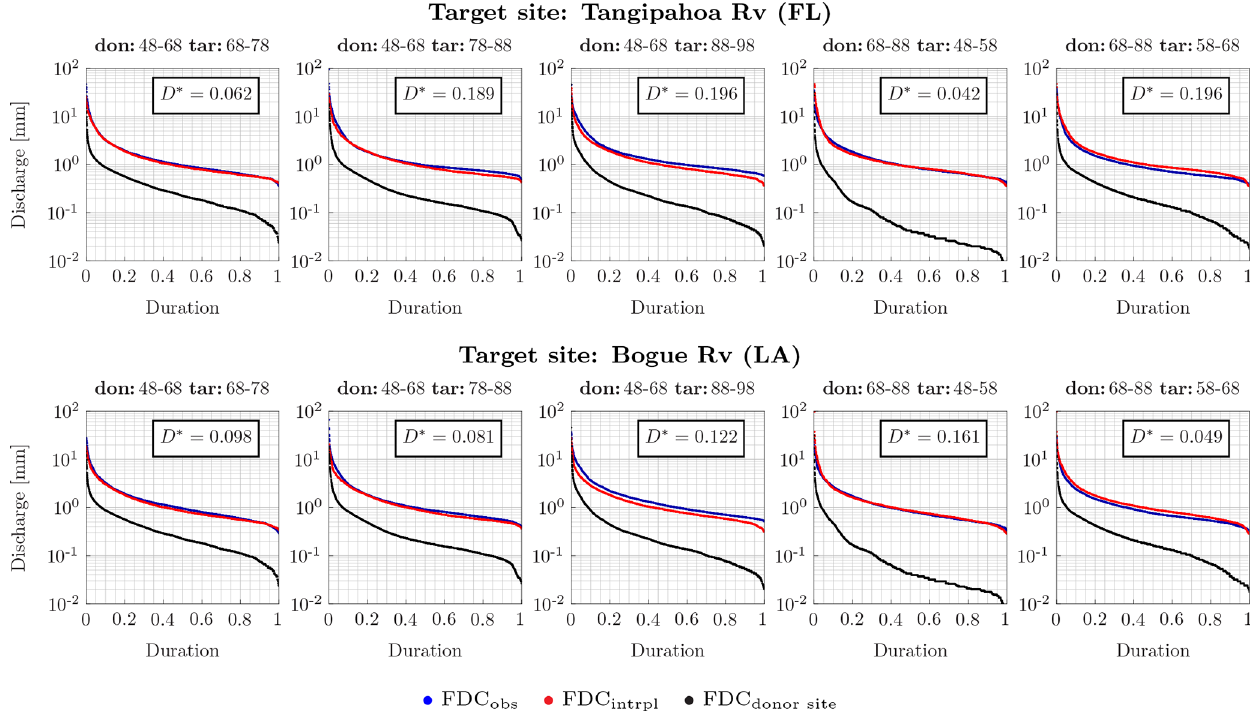
Figure 7. Interpolated FDC at Tangipahoa River (FL) and Bogue River (LA), in the upper and lower panels, respectively. The donor basin is Blanco River (TX). The donor years are a 20-year time window from October 1948 to September 1968 and from October 1968 to September 1988. Target years are the decades shown above each panel. Blue and red dots are the observed and interpolated FDC at the target basin during the target period, respectively; the black dots are the observed FDC at the donor basin during the target period. In each box the Kolmogorov–Smirnov distance between observed and interpolated values, D ∗ , is reported. The p value of the test is always around zero, but for Tangipahoa target years